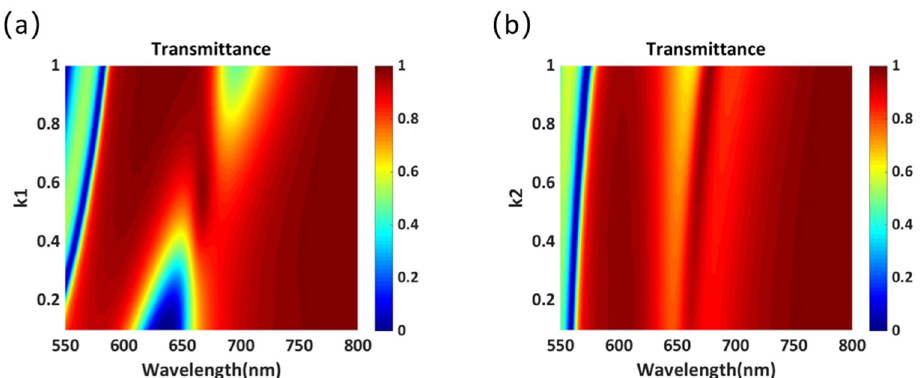
Figure 2. Transmittance of the proposed cross-shaped structure as a function of ( a ) k 1 and ( b ) k 2 .